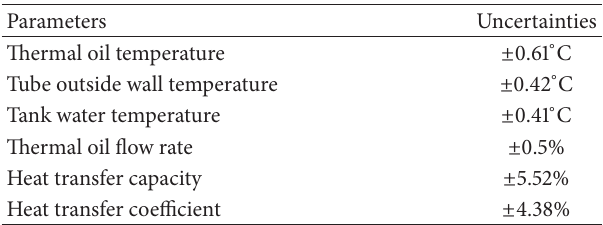
Table 2: Uncertainties of measured